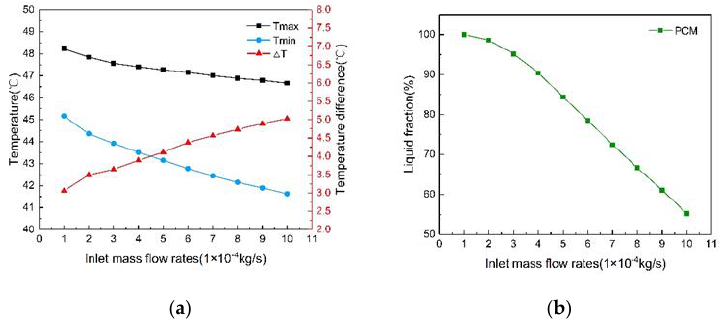
Figure 10. ( a ) T max , T min , and Δ T at different mass flow rates at 1800 s. ( b ) PCM liquid fraction at different mass flow rates at 1800 s.